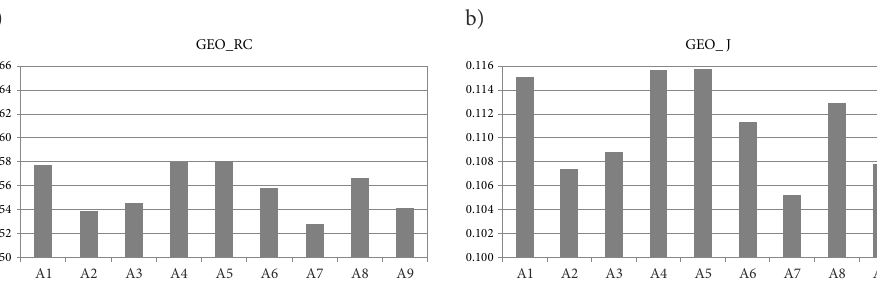
Figure 2. Rankings of gerontechnologies with the use of TOPSIS_GEO based on a) RC ( A i ), b)